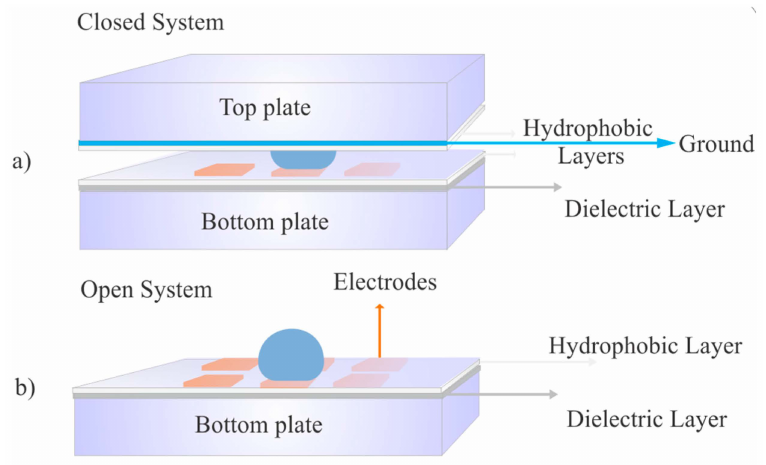
Figure 2. The DMF system in closed and open